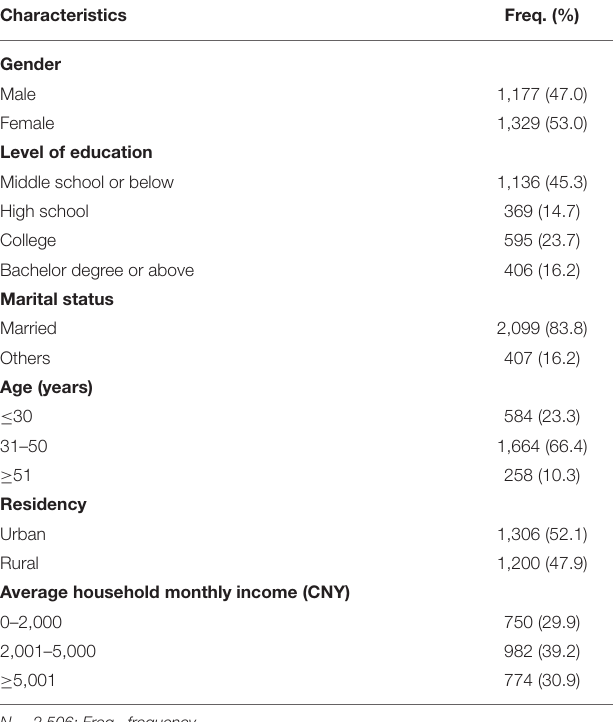
TABLE 1 | Demographic characteristics of respondents.